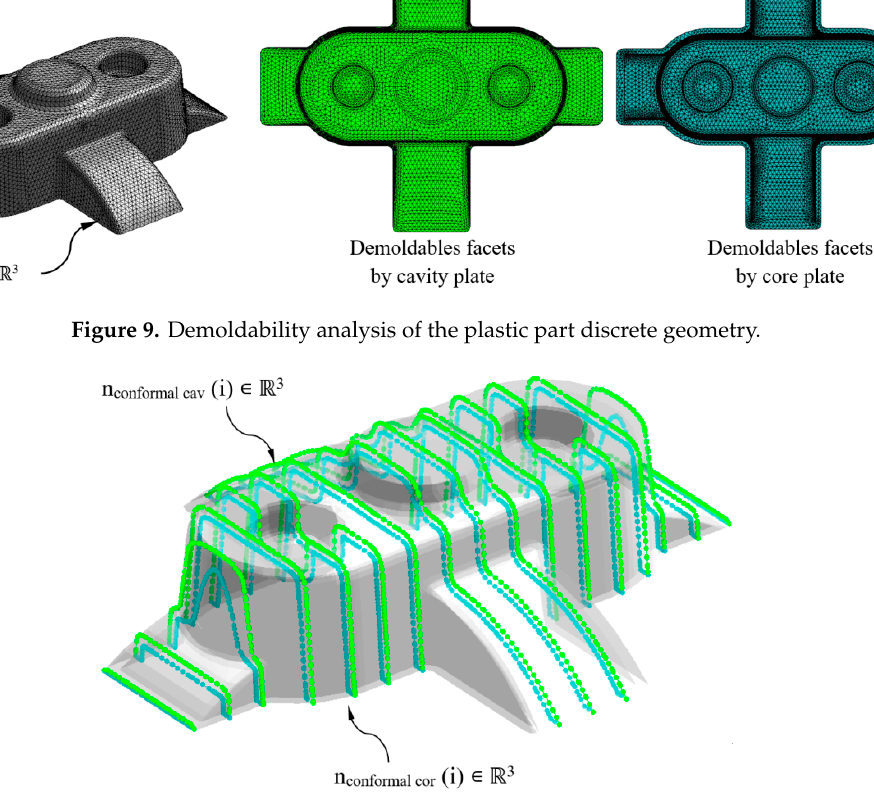
Figure 10. Definition of n conformal cav ∈ ℝ 3 y n conformal cor ∈ ℝ 3 for the generation of the pathing of the conformal cooling channels.